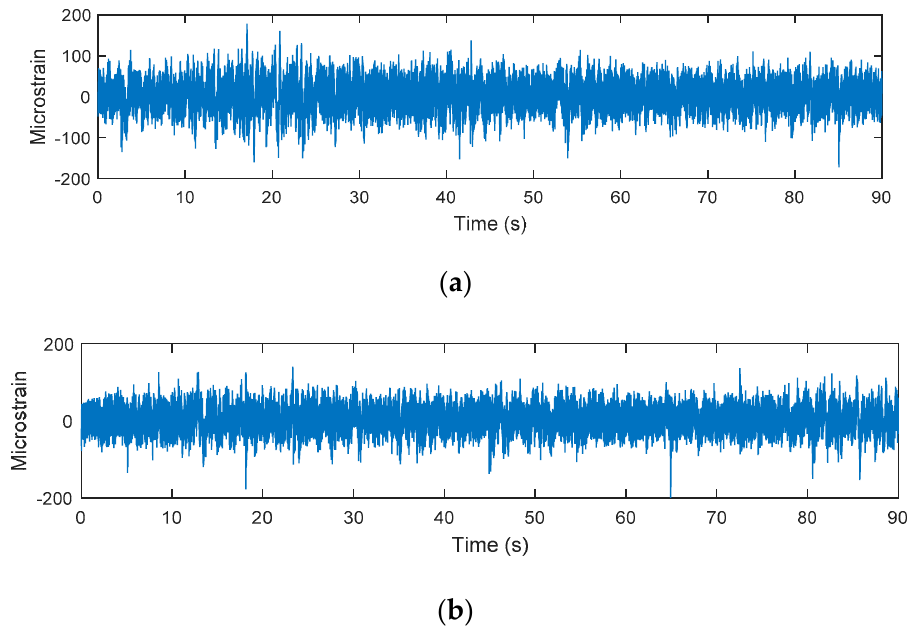
Figure 8. Elastic-energy model strain signals: ( a ) Highway A, ( b ) Highway B.